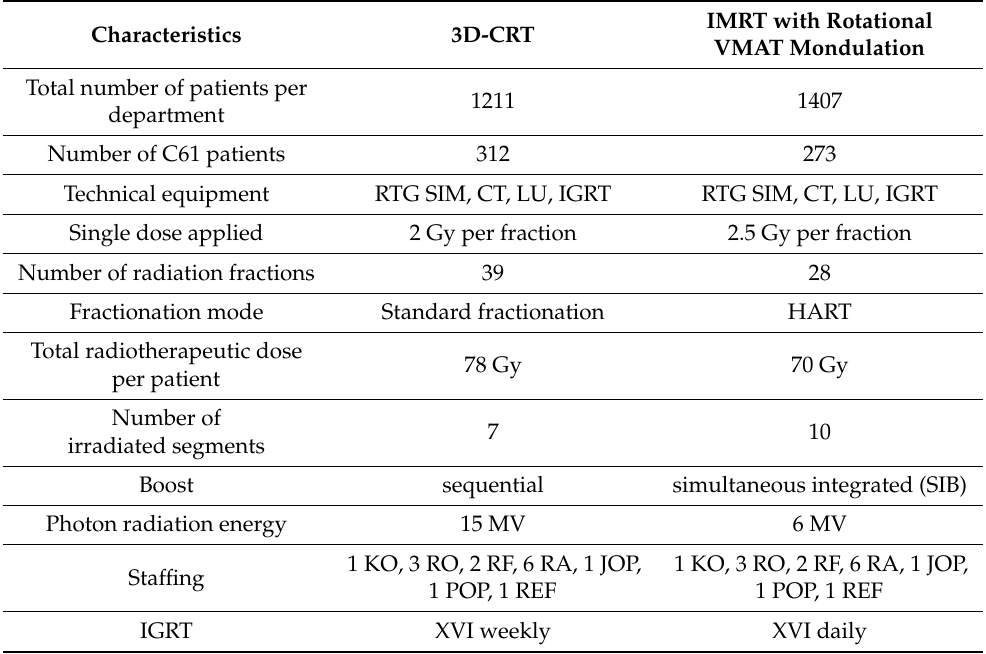
Table 2. Input data for radiotherapy modalities being compared—fractionation chart. Table 2 for a summary of the input data. Characteristics